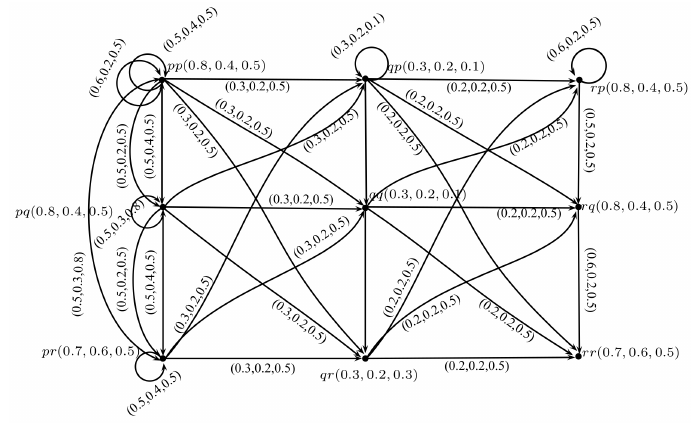
Figure 11. Neutrosophic digraph G 1 ◦ G 2 = ( RV 1 ◦ RV 2 , SE 1 ◦ SE 2 )